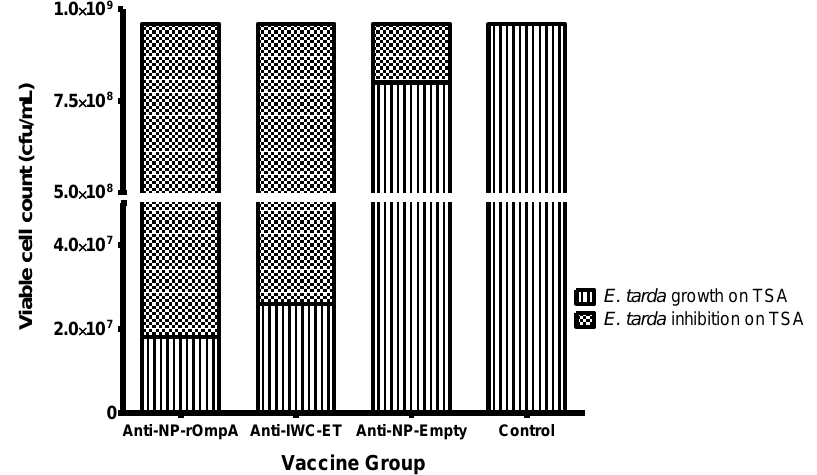
Figure 7. Shows E. tarda growth and inhibition on TSA after treatment of sera from vaccinated fish with cultured bacteria. The concentration of the bacteria used was 10 3 CFU/mL, to which 90 μL serially diluted sera were added in microfuge tubes followed by spread plate technique and incubation on TSA for 24 hr at 30 °C. Bacterial growth for each group was determined by counting individual colonies on TSA while inhibition was calculated by subtracting the bacterial colony counts of vaccinated fish from the control group. Note that serum samples from the NP-rOmpA, IWC-ET, and NP-Empty vaccines were designated as anti-NP-rOmpA, anti-IWC-ET, and anti-NP-Empty, respectively. The serum used in this study was pooled from blood samples of 10 fish collected at 51 dpv.